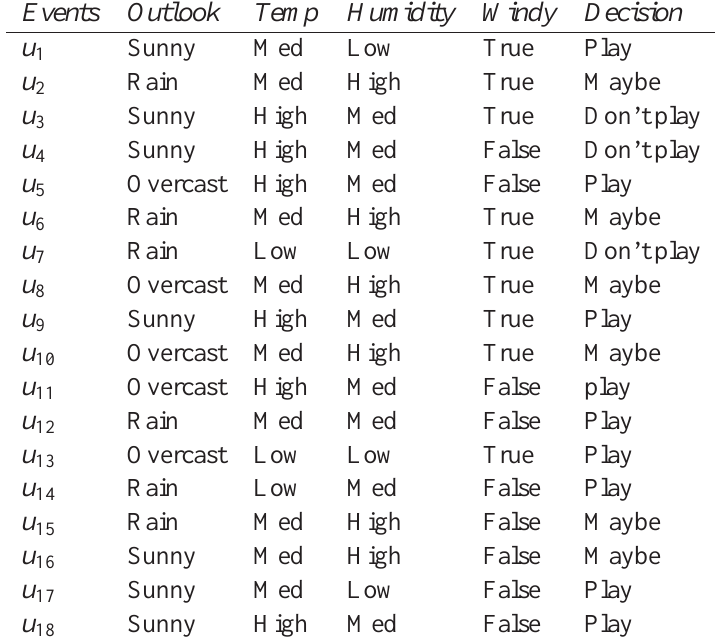
Table 6: The induced consistent decision system